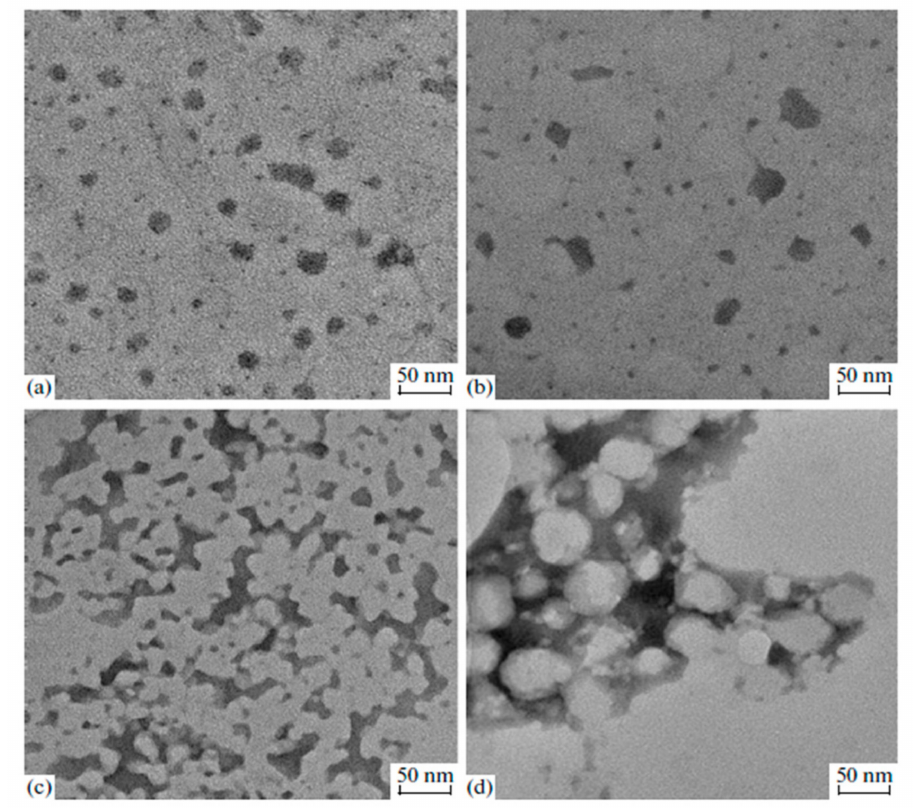
Figure7. TEMmicrographsofthedispersionsof( a )PU-35, ( b )PU-40, ( c )PU-45, and( d )PU-50; (hard / soft segment molar ratio of 3.5, 4.0, 4.5, and 5.0, respectively) [41]. Copyright © (2015) Pleiades Publishing.